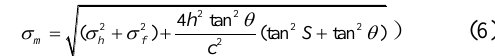
Figure2.(a), Figure3.(a), Figure4.(a)). The terrain height in the first region ranged from 706.7 m to 2414.6 m, that in the second region ranged from 1.4 m to 618.2 m, and that in the third region ranged from 1.3 m to 141.1 m; the names of these regions are Weinan, Lianyungang, and Tianjin, respectively.